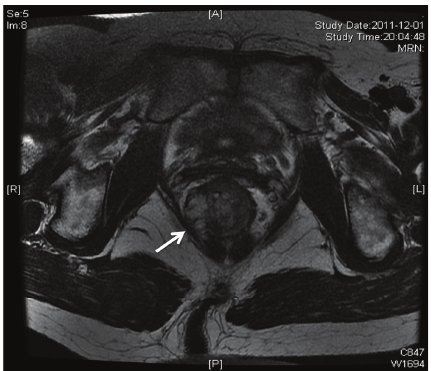
Figure 1: T2-weighted axial thin section magnetic resonance imag- ing scan. This scan shows a low rectal tumor with involvement of the potential circumferential resection margin (white